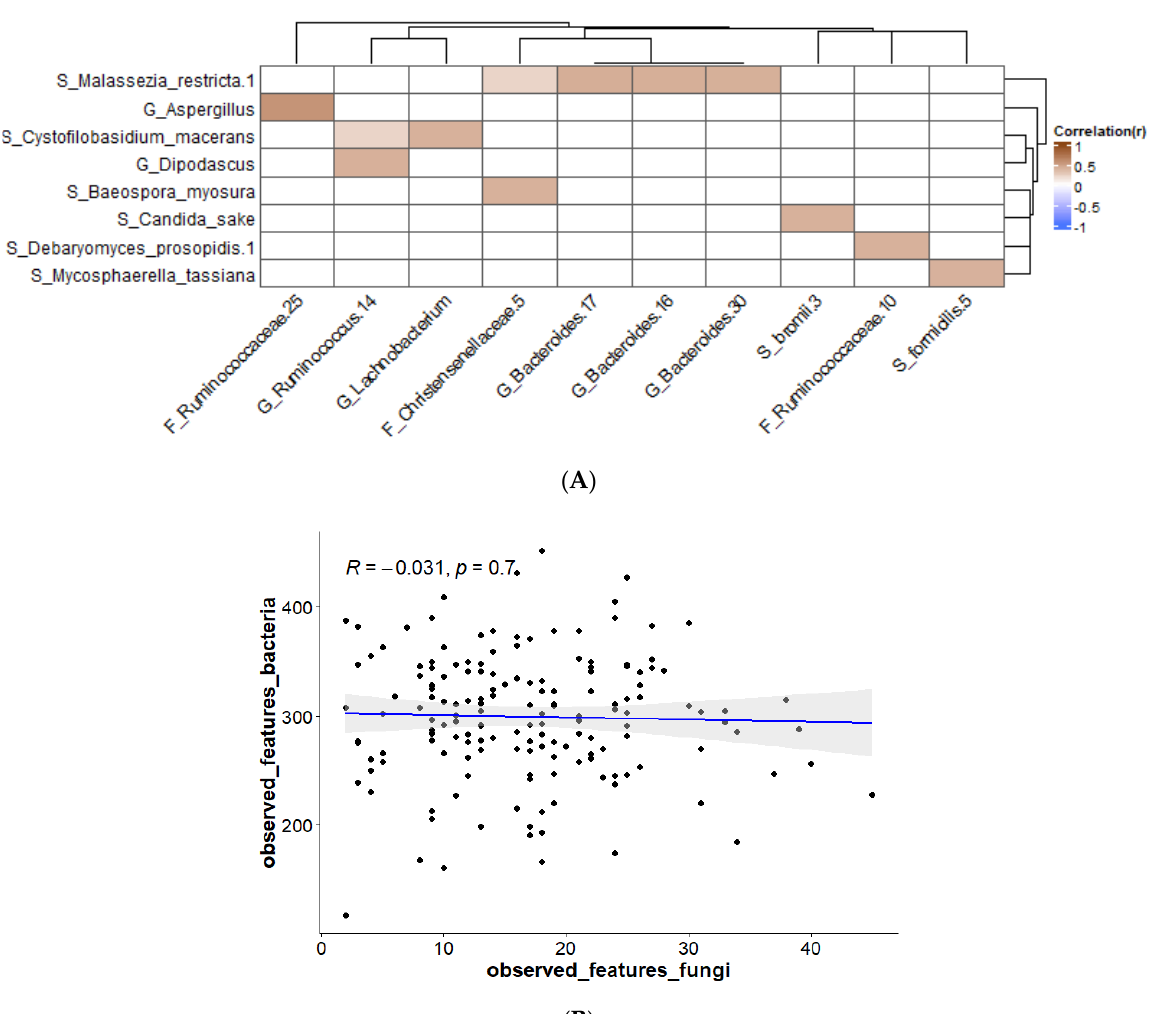
Figure 4. ( A ) Bacterial – fungal correlations using Spearman correlation present in ≥ 10% of samples; corrected p-value after FDR cut-off 0.1; ( B ) Spearman correlations for observed features at ASV levels for bacteria versus fungi.